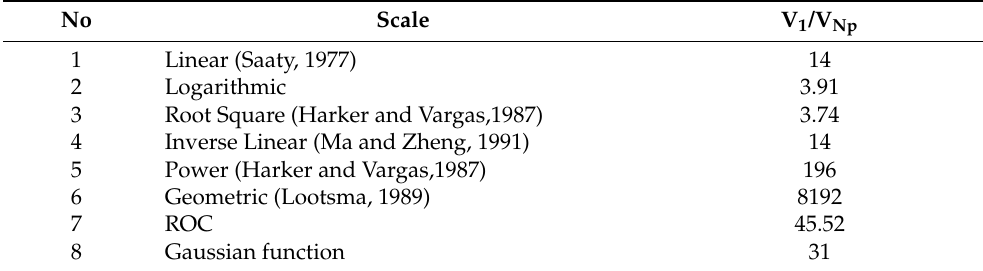
Table 3. V 1 /V Np of scales.